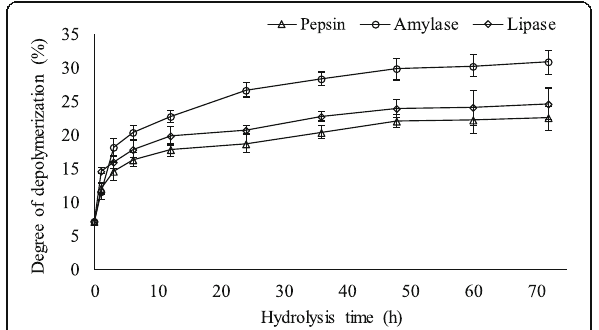
Fig. 1 Degree of depolmerization of chitooligosaccharides (COSs) from squid pen prepared using pepsin, amylase or lipase for diffrent hydrolysis times. Bars represent the standard deviation ( n = 3). Enzymes at 8% (w/w) were